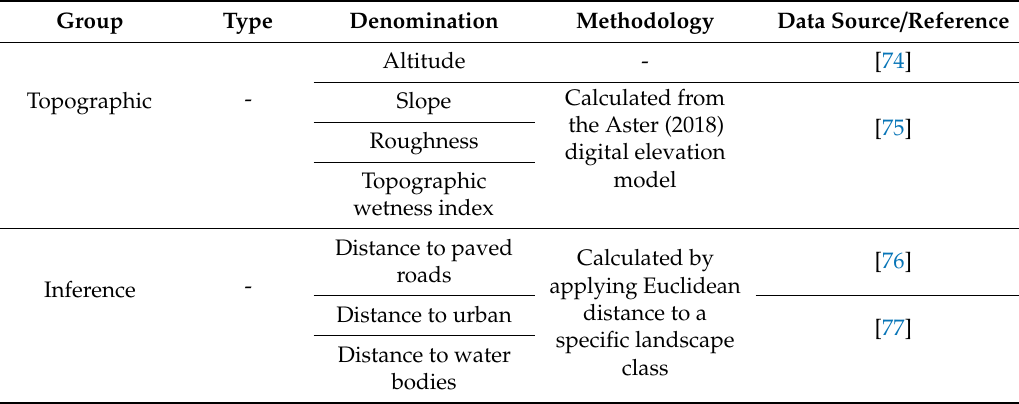
Table 2. Dataset not involving Sentinel-2A images and representing candidate static predictors.